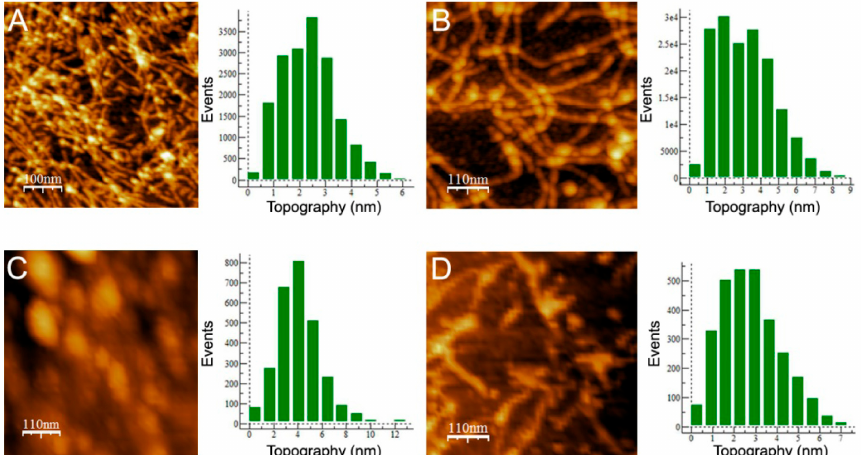
Figure 4. Atomic force micrographs of Gad m 1 amyloid assemblies. Images of the aggregation products of Gad m 1 ( A ) wt, ( B ) I12C, ( C ) C19S and ( D ) wt in presence of tris(2-carboxyethyl)phosphine hydrochloride (TCEP). Height histograms correspond to the full images.